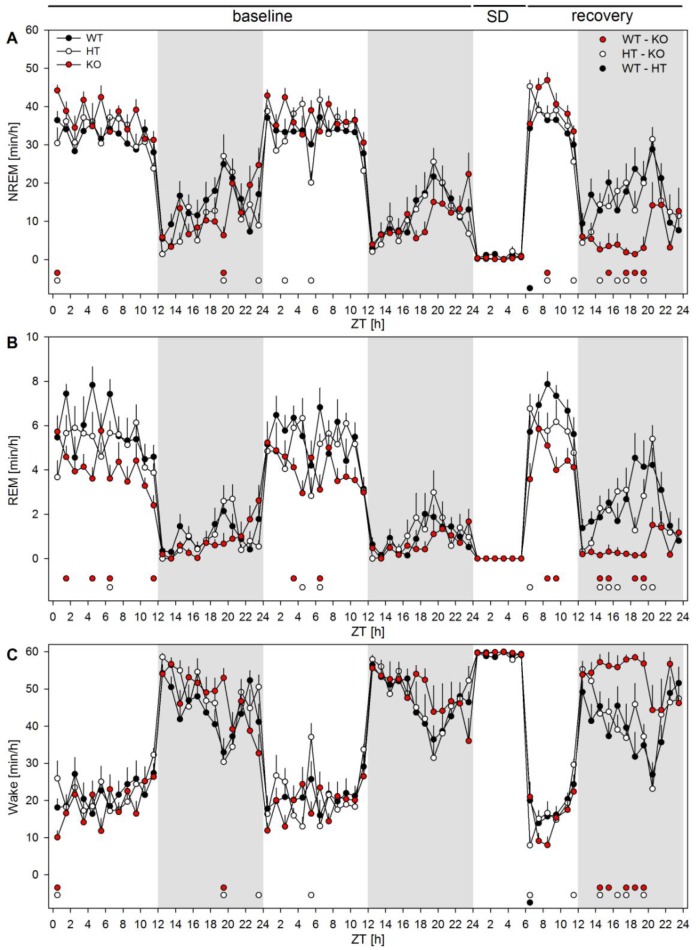
The effect of mGluR5 genotype across vigilance states and sleep deprivation in mice.The figure illustrates the time spent in each of the three vigilance states NREM sleep (top) REM sleep (middle) and wakefulness (bottom) in minutes per hour of recording in wild type (WT, black), heterozygote (HT, white) and Grm5 knock-out (KO, red) mice. After two baseline days 6 hr of sleep deprivation started at the beginning of the light phase and was followed by 18 hr recovery. Significant differences between the genotypes were observed at several time points across the 72 hr protocol. After sleep deprivation the KO mice showed a clear suppression of NREM sleep and increase of wakefulness. This effect is in sharp contrast to the NREM and REM sleep rebound observed in WT and HT mice at the cost of wakefulness. Overall repeated measures 2-way ANOVAs revealed significant ‘genotype x hour’ interaction for all three vigilance states (F46,483 > 2.38, pall < 0.0001), n = 8 mice/genotype. Post-hoc testing was performed by hourly one-way ANOVAs with factor ‘genotype’, followed by Holm corrected t-tests; baseline 1: NREM sleep F2,21 > 3.8, p all < 0.04, WT – KO (red dots) and HT – KO (white dots) pall < 0.04; REM sleep F2,21 > 5.7, p all < 0.02, WT – KO p all <0.02, HT – KO p all <0.05; Wake F2,21 > 4.0, pall <0.04, WT – KO and HT – KO pall < 0.04; baseline 2: NREM sleep F2,21 > 3.8, pall < 0.04, HT – KO pall < 0.04; REM sleep F2,21 > 3.9, pall < 0.04, WT – KO pall < 0.02, HT – KO pall < 0.05; Wake F2,21 > 6.8, HT – KO p<0.003; recovery: NREM sleep F2,21 > 3.8, pall < 0.04, WT – KO pall < 0.05, HT – KO pall < 0.03, WT – HT (black dots) pall < 0.01; REM sleep F2,21 > 4.9, pall < 0.02, WT – KO pall < 0.05, HT – KO pall < 0.03; Wake F2,21 > 3.8, pall < 0.04, WT – KO pall < 0.05, HT – KO pall < 0.04, WT – HT pall < 0.02.